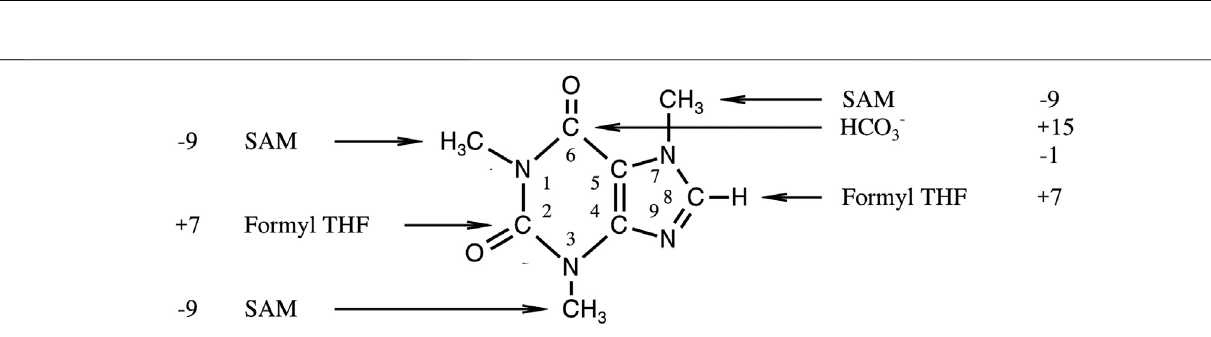
Frontiers in Chemistry |